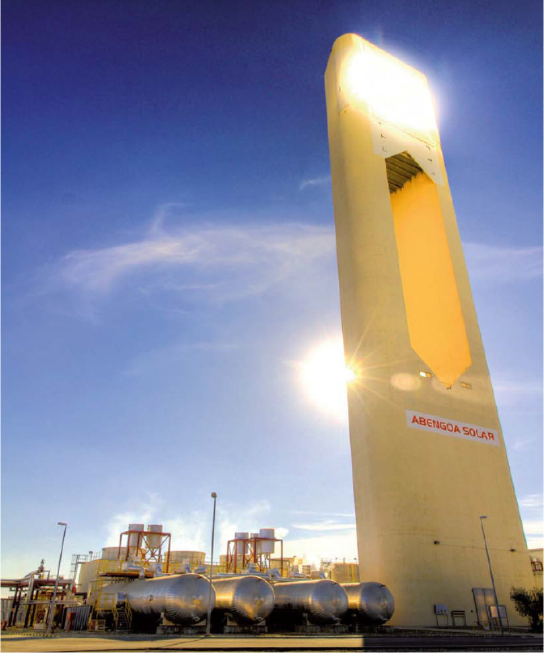
Figure 2. Steam accumulators of PS10 plant (Source: Abengoa).